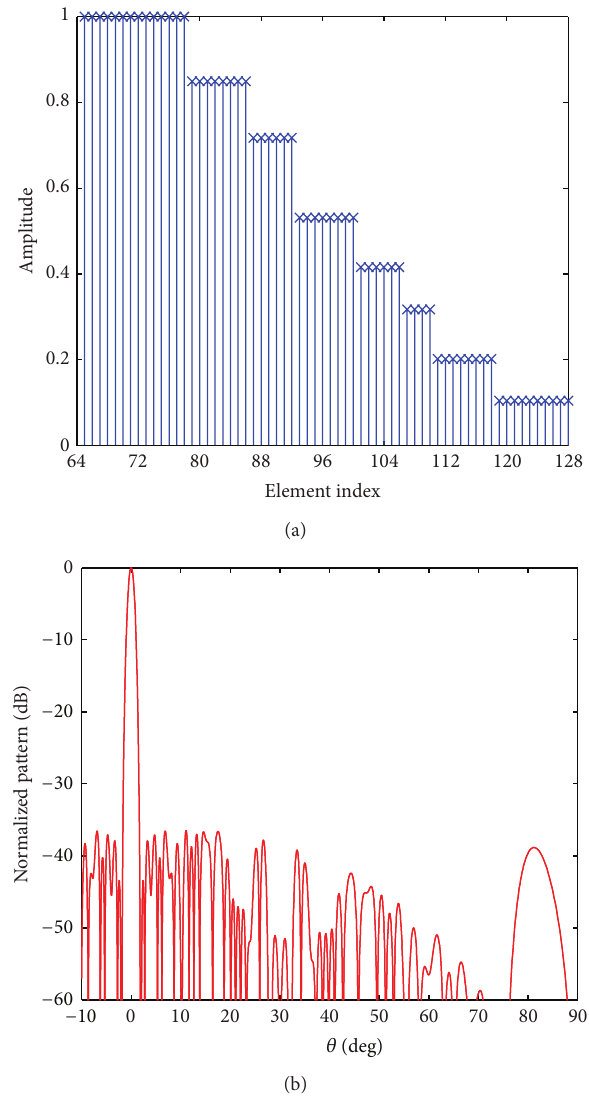
Figure 4: The optimization results of the linear array: (a) the opti- mized subarray sizes and amplitude weights and (b) the optimized array